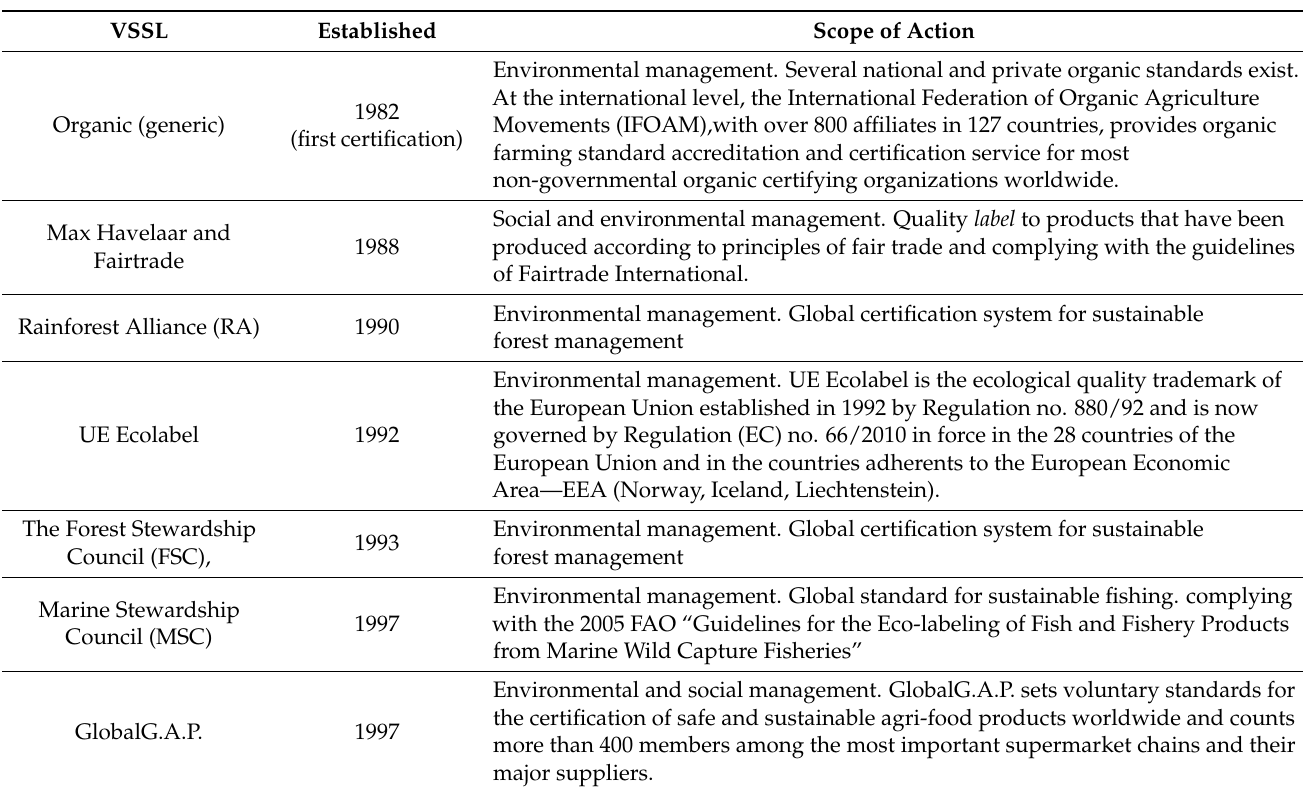
Table 1. Principal voluntary sustainability standards and labels (VSSL) at the global level in the agri-food sector.